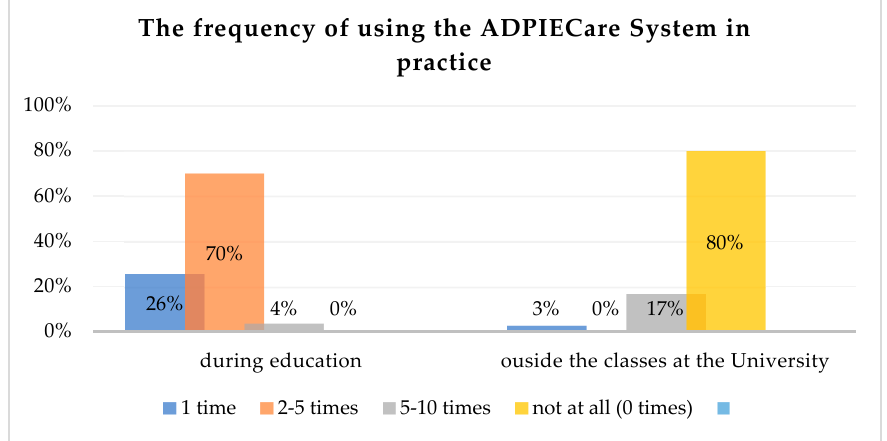
Figure 9. Frequency of using the ADPIECare system. As the answers in Figure 10 demonstrate, as many as 80% of the respondents did not have any contact with the application outside of the training course. Much fewer people, only 17%, used the tool for their own purposes from 5 to 10 times; 3% of people used it only once (Figure 10).